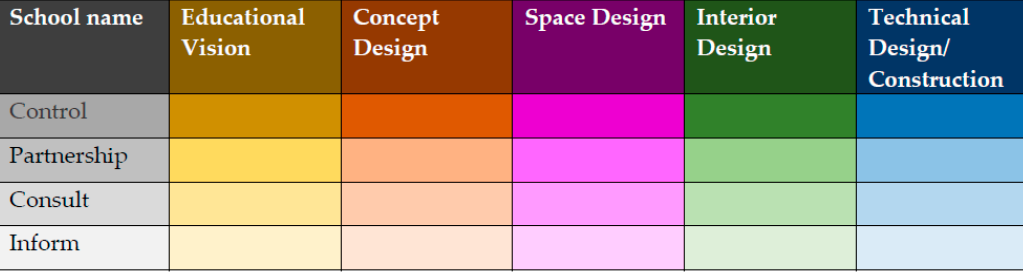
Figure 4. The ECSIT model, consisting of educational vision, concept design, space design, interior design, and technical design and construction.